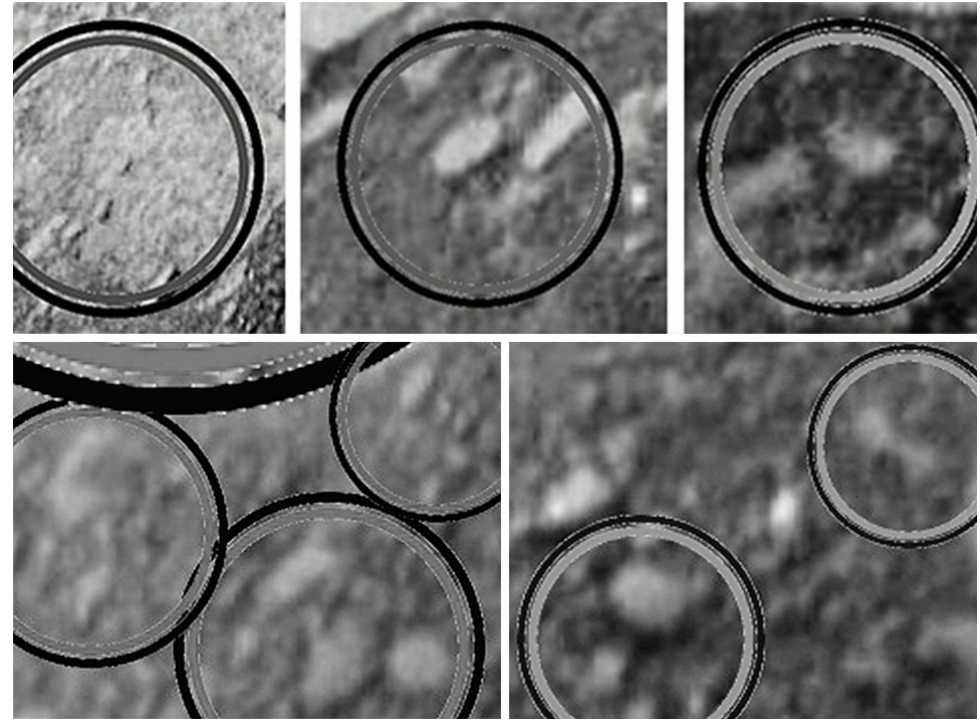
Figure 5. Venus: Specimens resembling fungal-mushrooms. Photographed near the landing struts of the 1982 Soviet probe VENERA-13. (Reproduced with permisison from Joseph 2019).